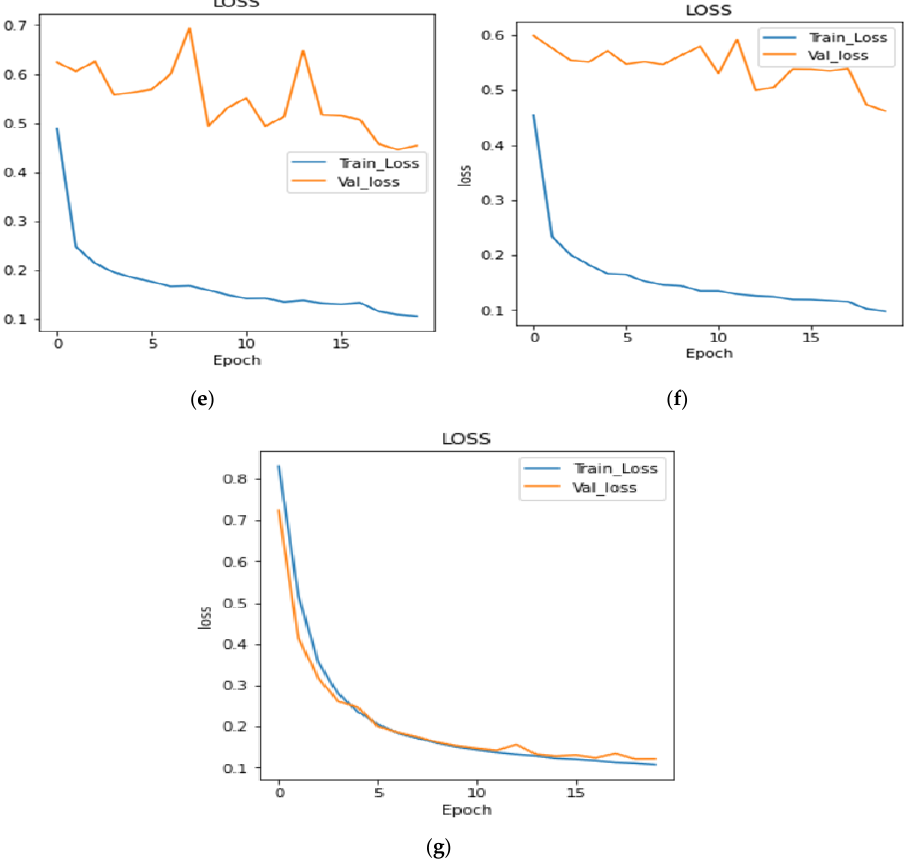
Figure 8. Loss Plots: ( a ) DenseNet121, ( b ) Inception V3, ( c ) SeResNet50, ( d ) VGG19, ( e ) Inception ‐ ResNetV2, ( f ) EfficientNet B2, & ( g ) Proposed U ‐ Net.